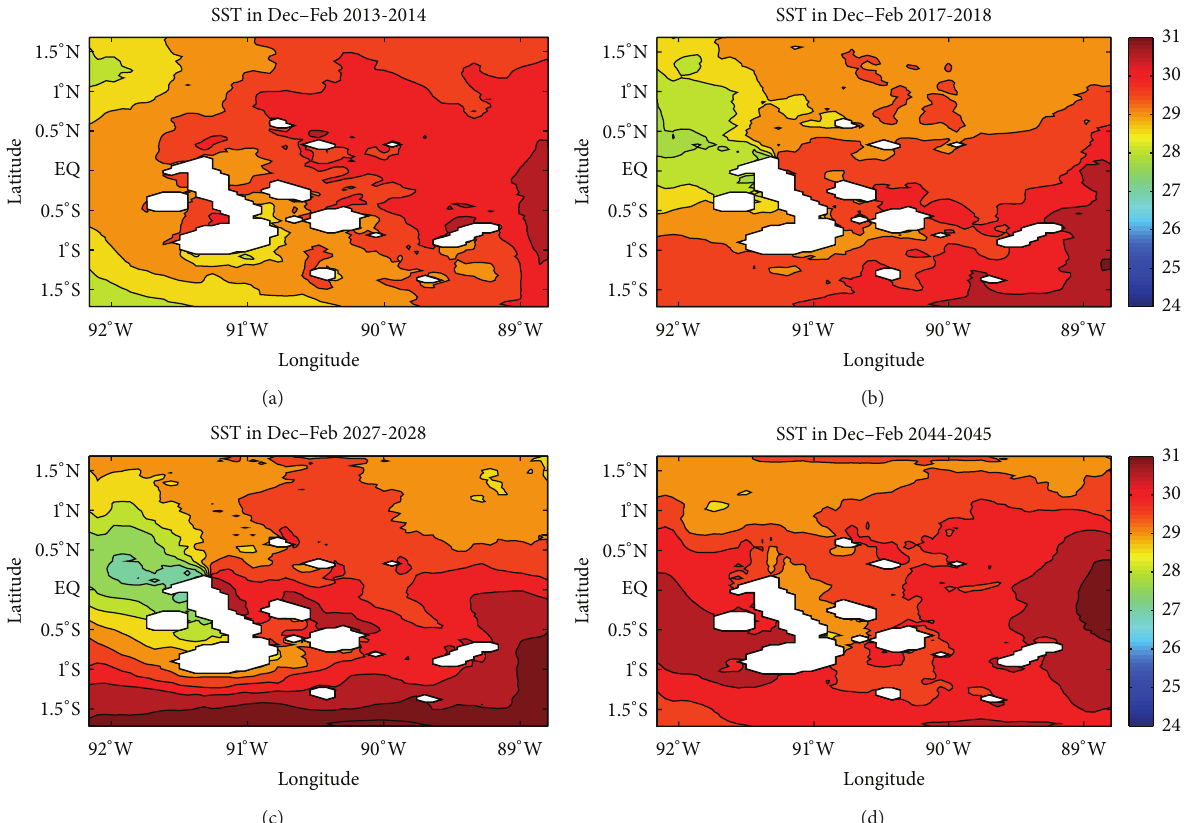
Figure 9: The SST around the GMR during the El Ni˜no cases: (a) in Dec–Feb in 2013-2014, (b) in Dec–Feb in 2017-2018, (c) in Dec–Feb in 2027-2028, and (d) in Dec–Feb in 2044-2045. been vertically remapped to hybrid vertical